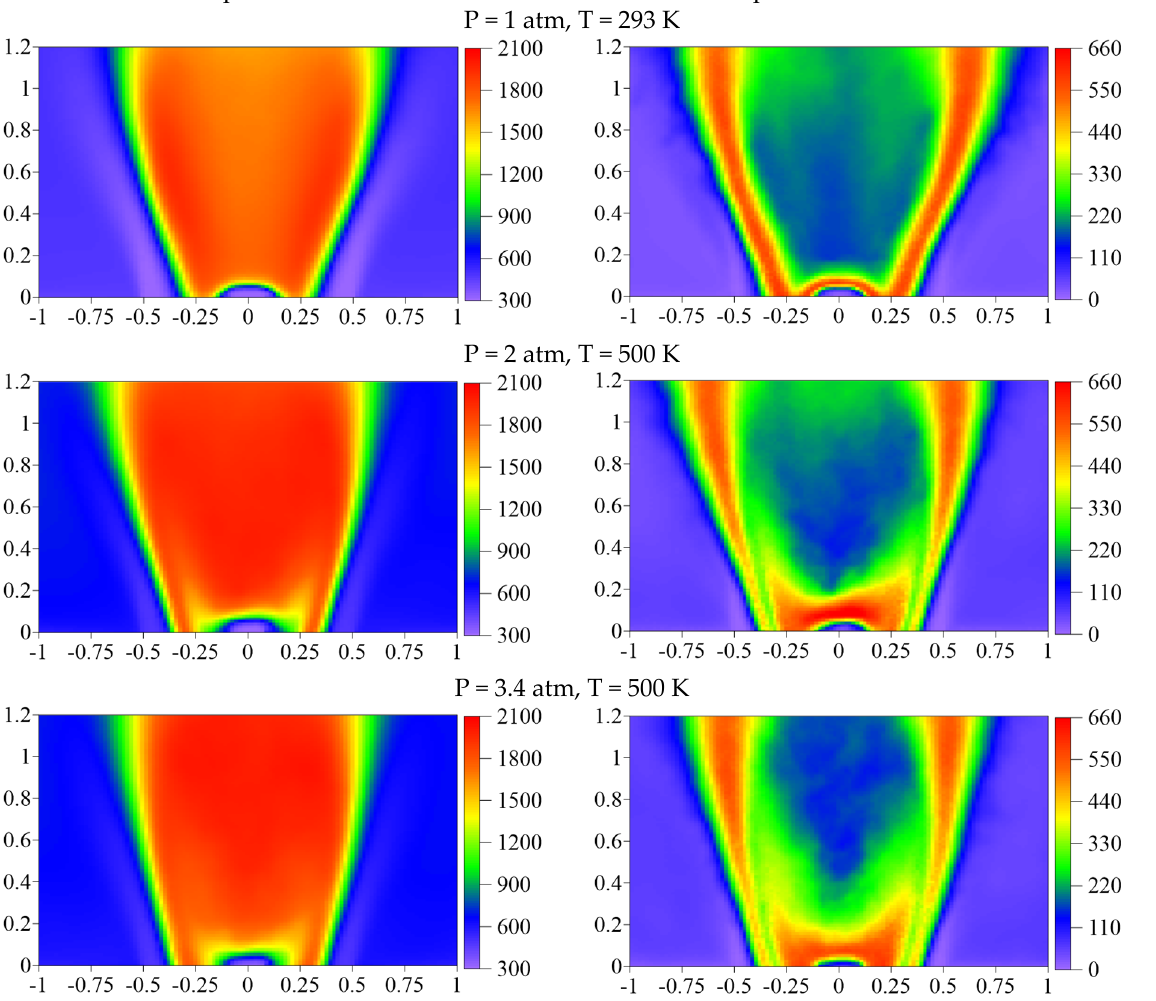
Figure 6. Mean temperature fields and RMS of the temperature fluctuations evaluated by the LES approach. LES